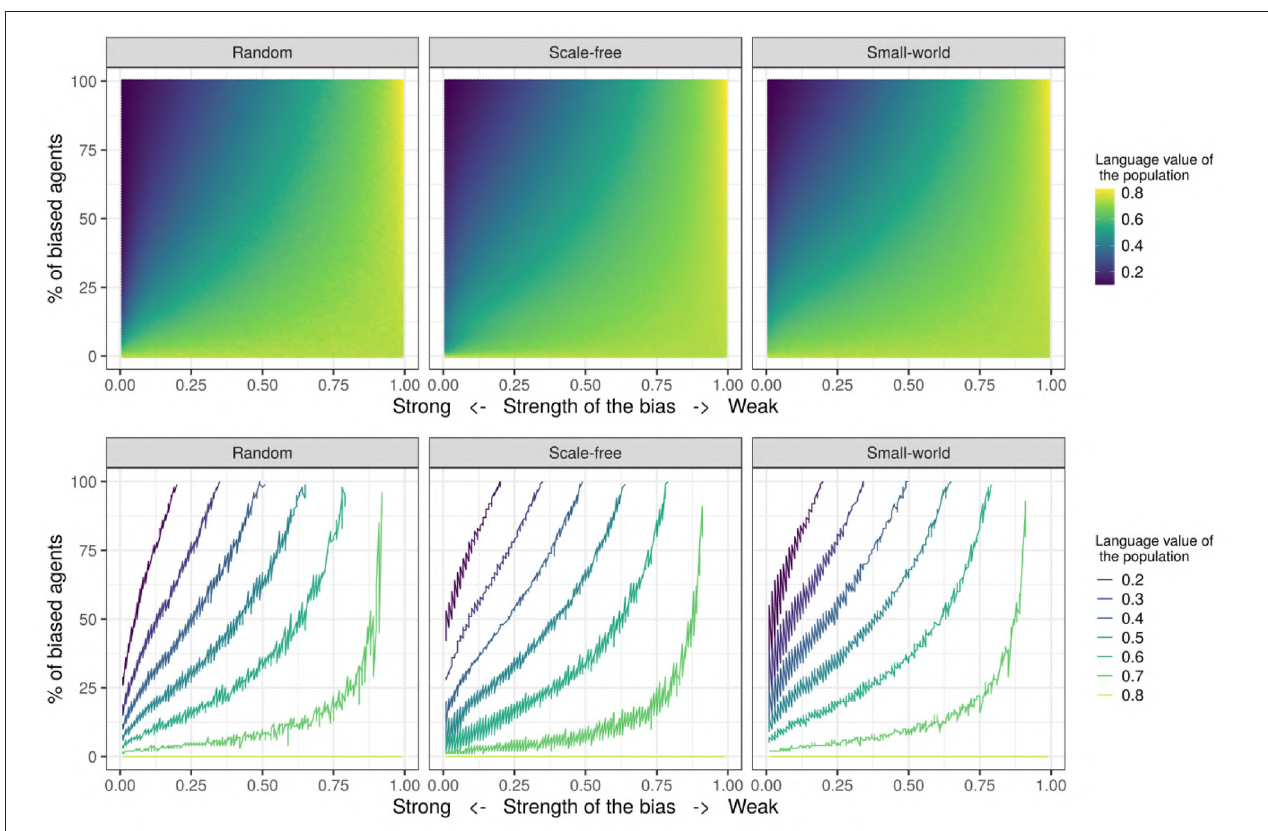
FIGURE 8 | (Top) The aggregated mean language value (color) function of bias strength (horizontal axis, systematically varying between 0.0 and 1.0 in steps of 0.01) and proportion of biased agents in the population (vertical axis, varying between 0 and 100% in steps of 1%). For each of the possible combinations of these two parameters, a colored dot indicates the aggregated mean language value of the population. (Bottom) The different language values are plotted with isolines, in contrast to the continuous scale used in the figure on the top. The isolines are the maximum values of the combination of bias_strength and prop_biased for a set of language values, and color represents the value of the language isolines. We used a network with an initial language, containing 150 SAM